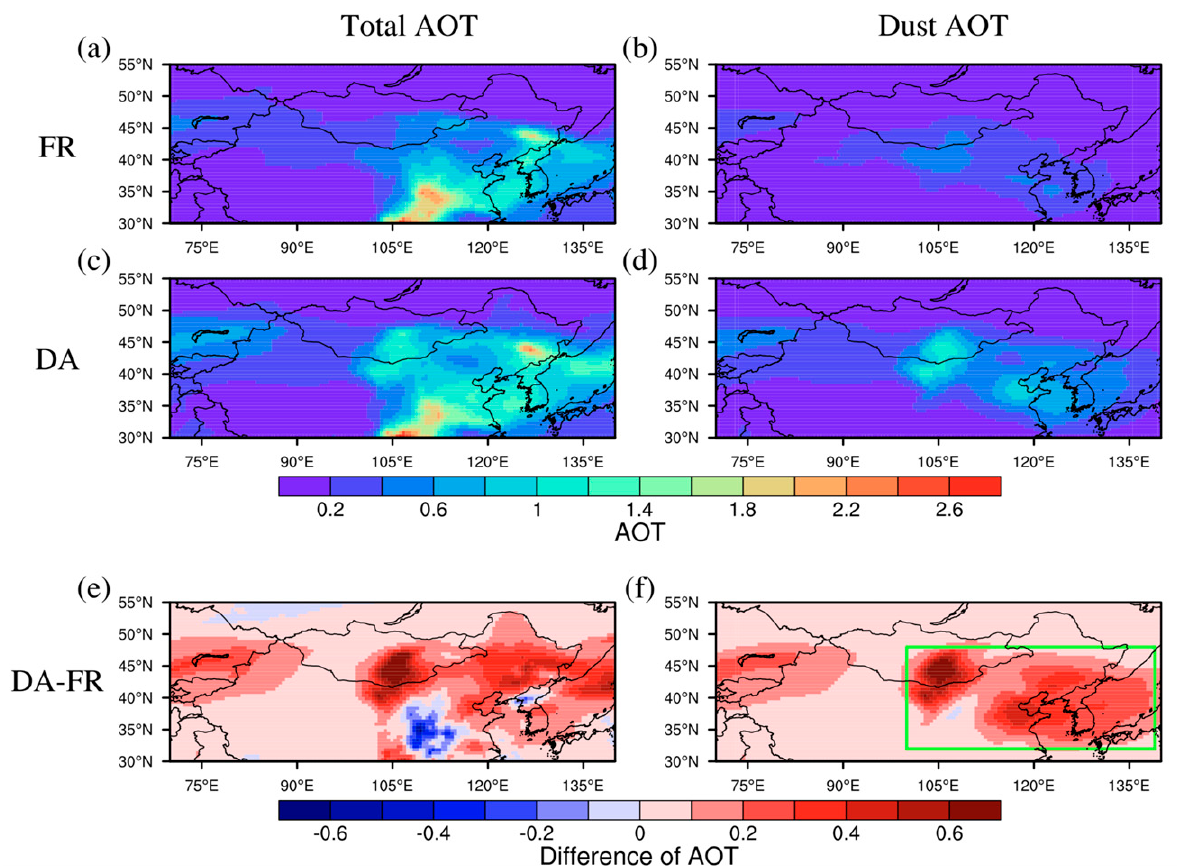
Figure 2. Spatial distributions of total AOTs and dust AOTs averaged from 28 to 31 March 2018 over East Asia for ( a , b ) FR and ( c , d ) DA experiments. ( e , f ) Differences in AOTs between the two experiments. Rectangle in green shown in lower-right panel represents the key areas of focus here.